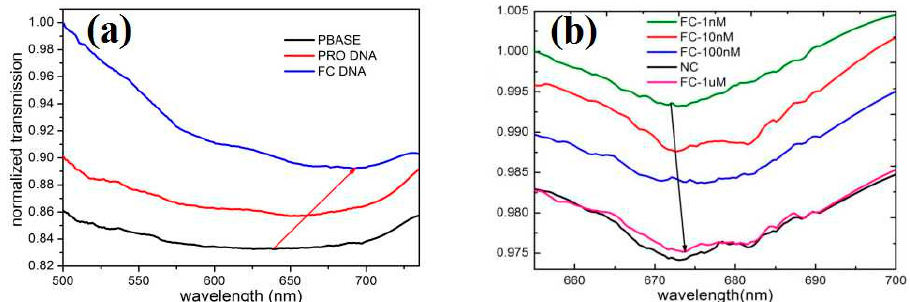
Figure 8. ( a ) The normalized transmission spectra after the addition of PBASE, probe DNA and tDNA to the D-type region. ( b ) The normalized transmission spectra of different concentrations of full complementary (FC) and non-complementary (NC) DNA.